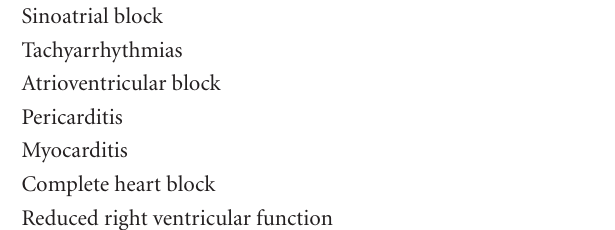
Table 1: Cardiovascular complications associated with RSV infec-